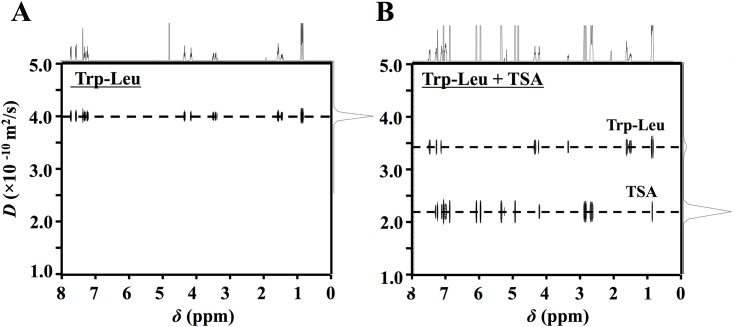
DOSY-NMR spectra of Trp-Leu alone (A) and complex with TSA (B).The spectrum (B) shows a mixture of 3 mM Trp-Leu and 3 mM TSA. DOSY-NMR measurements were performed using the spin-echo method at a field gradient pulse between 0.05 and 0.3 T/m at 25°C.